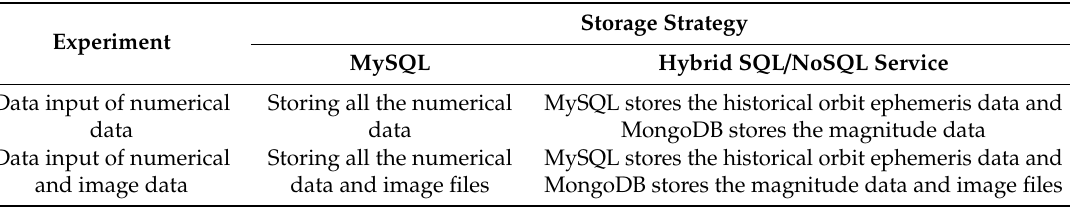
Table 2. Storage strategies and experimental